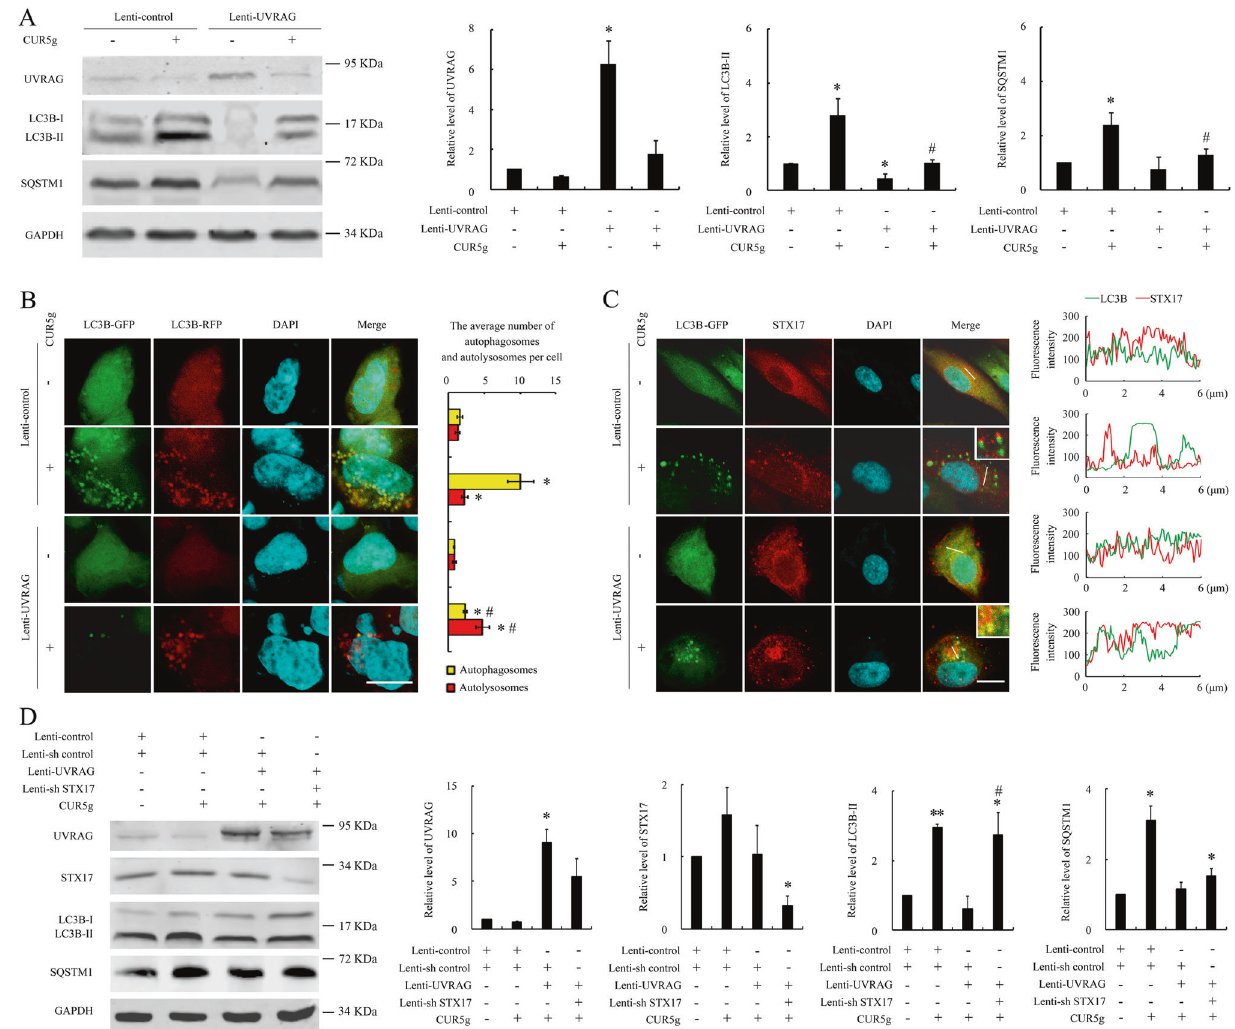
Fig. 5 Overexpression of UVRAG reversed the inhibitory effect of CUR5g on autophagy, which can be eliminated by knocking down STX17. A Western blot analysis of UVRAG, LC3B-II, and SQSTM1 levels in A549 cells transfected with control lentivirus or UVRAG lentivirus in the presence of DMSO or CUR5g (10 μ M) for 24 h. GAPDH was used as a loading control. ( n = 3; * p < 0.05 vs. Lenti-control, # p < 0.05 vs. Lenti- control + CUR5g). B Representative fl uorescence photographs of HEK293T cells stably expressing RFP-GFP-LC3B reporter. Cells were transfected with control lentivirus or UVRAG lentivirus in the presence of DMSO or CUR5g (10 μ M) for 24 h. Nuclei were stained with DAPI. Scale bar = 10 μ m. Histogram shows average number of autophagosomes (yellow) and autolysosomes (red) per cell. ( n = 3; * p < 0.05 vs. Lenti- control, # p < 0.05 vs. Lenti-control + CUR5g). C Representative fl uorescence images of the colocalization of LC3B (green) and STX17 (red). Cells were transfected with control lentivirus or UVRAG lentivirus in the presence of DMSO or CUR5g (10 μ M) for 24 h. Nuclei were stained with DAPI. The line-scanned pro fi les at the right of each confocal image show the distribution of fl uorescence for each channel in the white line in the corresponding confocal images. Scale bar = 10 μ m. D Western blot analysis of UVRAG, STX17, LC3B-II, and SQSTM1 levels in A549 cells transfected with control lentivirus, control shRNA lentivirus, UVRAG lentivirus or/and STX17 shRNA lentivirus in the presence of DMSO or CUR5g (10 μ M) for 24 h. GAPDH was used as a loading control. ( n = 3; * p < 0.05, * p < 0.01 vs. Lenti-control + Lenti-sh control, # p < 0.05 vs. Lenti- sh control + Lenti-UVRAG +